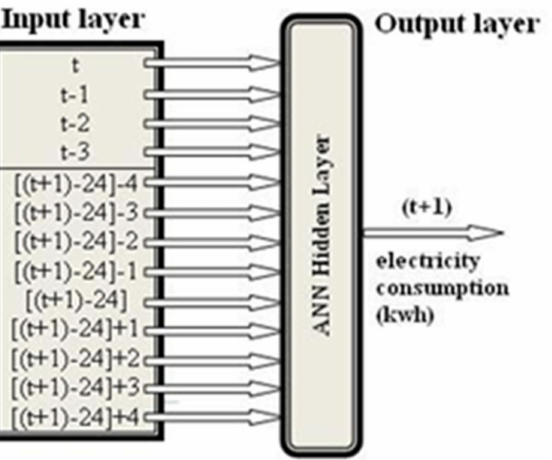
Figure 2. Typical architecture of a feed-forward multi-layer perceptron artificial neural (MLP-ANN) (modified from [47]).